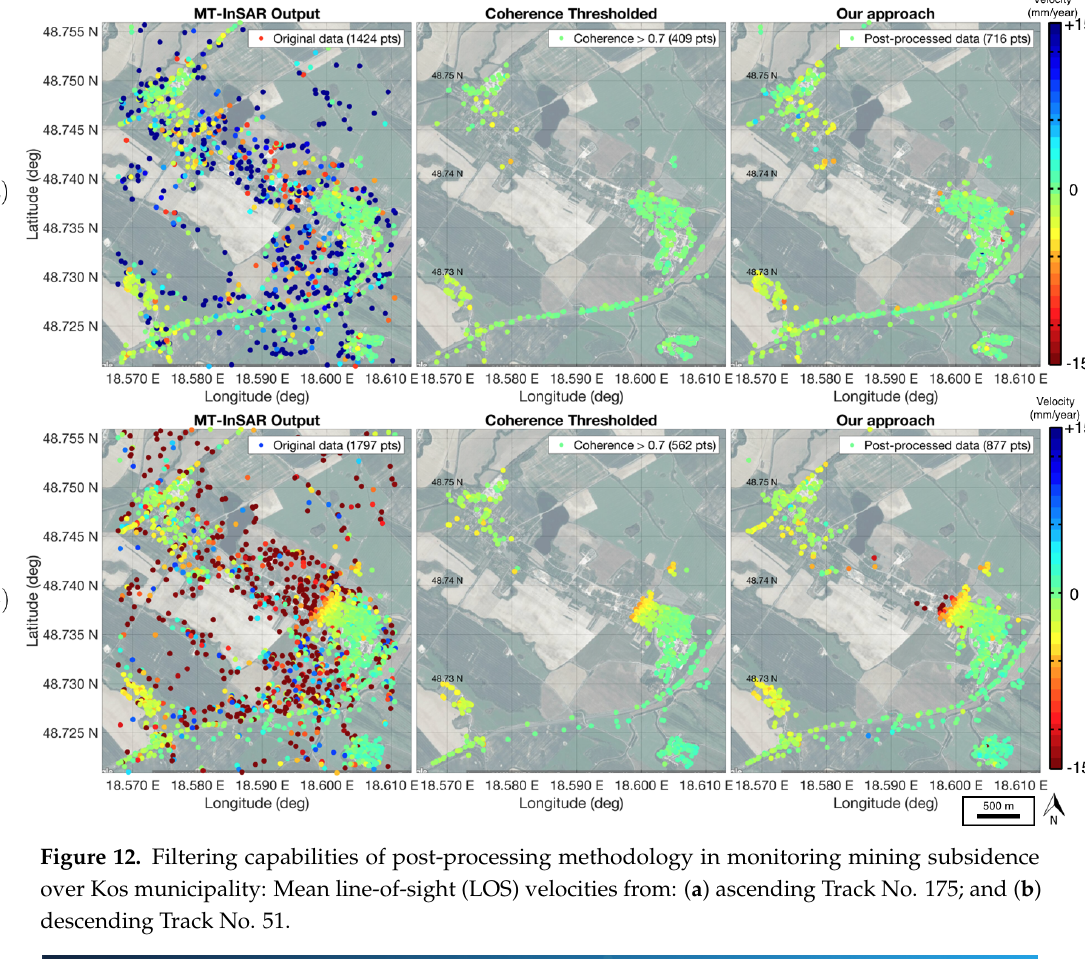
Figure 12. Filtering capabilities of post-processing methodology in monitoring mining subsidence over Kos municipality: Mean line-of-sight (LOS) velocities from: ( a ) ascending Track No. 175; and ( b ) descending Track No. 51.